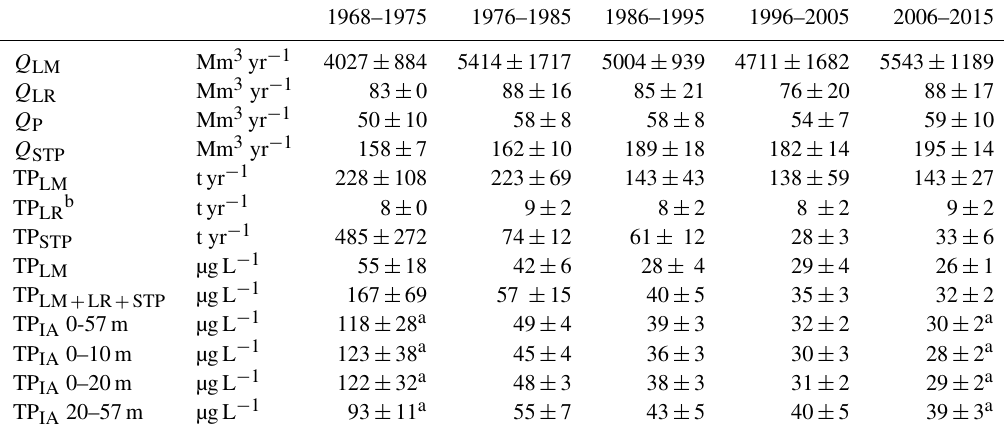
Table 1. Period means of annual water discharge ( Q ), total phosphorus (TP) load, and volume-weighted input TP concentrations ( ± standard deviation). The volume-weighted TP concentration in the whole water mass and in the surface layers of the model area are also shown. LM: Lake Mälaren; LR: local runoff; P: precipitation; STP: sewage treatment plants; IA: inner archipelago.